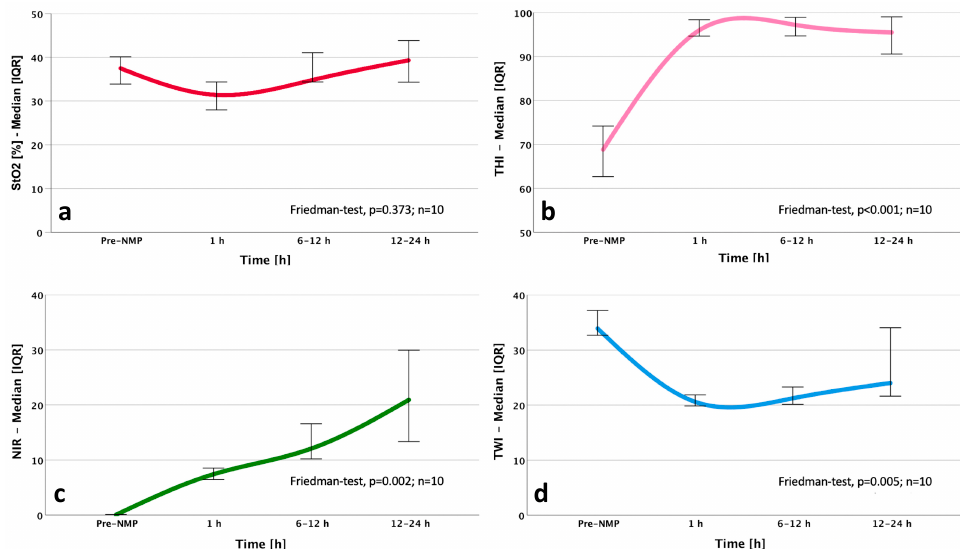
Figure 3. Courses of hyperspectral imaging (HSI) indices during normothermic machine perfusion (NMP) applied on human livers ( a ) Dynamics of tissue oxygen saturation index (StO2%), ( b ) tissue hemoglobin index (THI), ( c ) near-infrared perfusion index (NIR), and ( d ) tissue water index (TWI) during NMP of human livers ( n = 10) in a clinical setting. NMP time was extended to a maximum of 24 h. HSI measurements were performed before starting NMP, after 1 h NMP, 6–12 h NMP, and 12–24 h NMP. In a retrospective analysis, markers representing the region of interest were inserted into the pseudo-colored images, and the index averages from the values inside the region of interest were calculated. Applied statistic test: Friedman Test, p values < 0.05 were considered significant. HSI: hyperspectral imaging; THI: tissue hemoglobin index; StO2%: oxygen saturation index; NIR: near infrared perfusion index; TWI: tissue water index; NMP: normothermic machine perfusion.